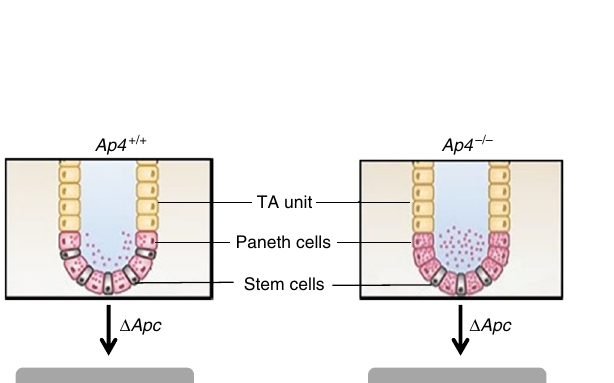
Fig. 9 Ap4 mRNA expression and associations in human CRCs deposited at TCGA and its correlative analysis of AP4, NICD1 and HES1 protein expression in human CRCs. a Ap4 RNA expression levels from matched patient samples from normal mucosa and tumor tissue (left), or unmatched normal mucosa and tumor tissues (right). RNA expression data were obtained from publically available TCGA colorectal adenocarcinoma (COAD) datasets 31 . Left panel: matched samples, 41 normal mucosa and 41 tumor tissue samples. Right panel: 41 normal mucosa samples and 462 tumor tissue samples were used. b Expression of human homologs of the Lgr5-positive stem cell signature 14 , members of the HALLMARK Wnt signaling gene set 33 or c-Myc target genes 33 are strongly linked with Ap4 expression in human tumors. All genes within the TCGA datasets from human colorectal tumors were pre-ranked by expression correlation coef fi cient (Pearson r ) with Ap4 in descending order from left (positive correlation) to right (negative correlation) and analyzed by GSEA. c Scatter plots displaying pairwise comparisons of mRNA expression levels [RSEM] of the indicated genes for 462 TCGA COAD samples. The correlation coef fi cients and p -values of Pearson´s and Spearman's correlations, as well as the linear regression trend line are indicated. d Left: dot plots displaying pairwise comparisons of IHC staining scores (see Supplementary Fig. 10b for more information) for AP4, NICD and HES1 from 220 human CRC tumor microarray (TMA) samples. Dot sizes represent tumor sample numbers. Right: Heatmap displaying Pearson r correlation coef fi cients of IHC scores obtained from 220 tumor samples stained for AP4, NICD1 and HES1 expression. a Left panel: results were subjected to a paired, two-tailed Student ’ s t -test with p- values * < 0.05, ** < 0.01, *** < 0.001. a Right panel and b results represent the mean ± SD. Results were subjected to an unpaired, two-tailed